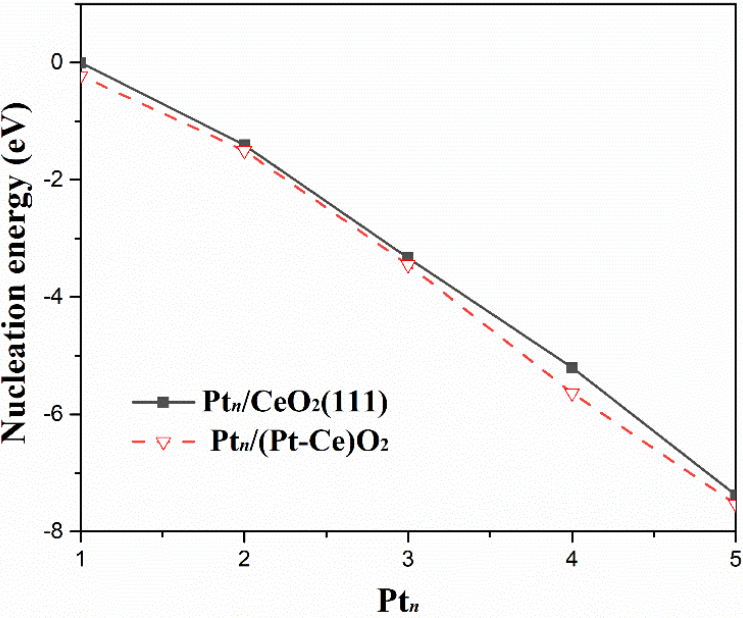
Figure 3. Nucleation energies as a function of the number of Pt atoms in the Pt n cluster on CeO 2 and (Pt−Ce)O 2 surface.